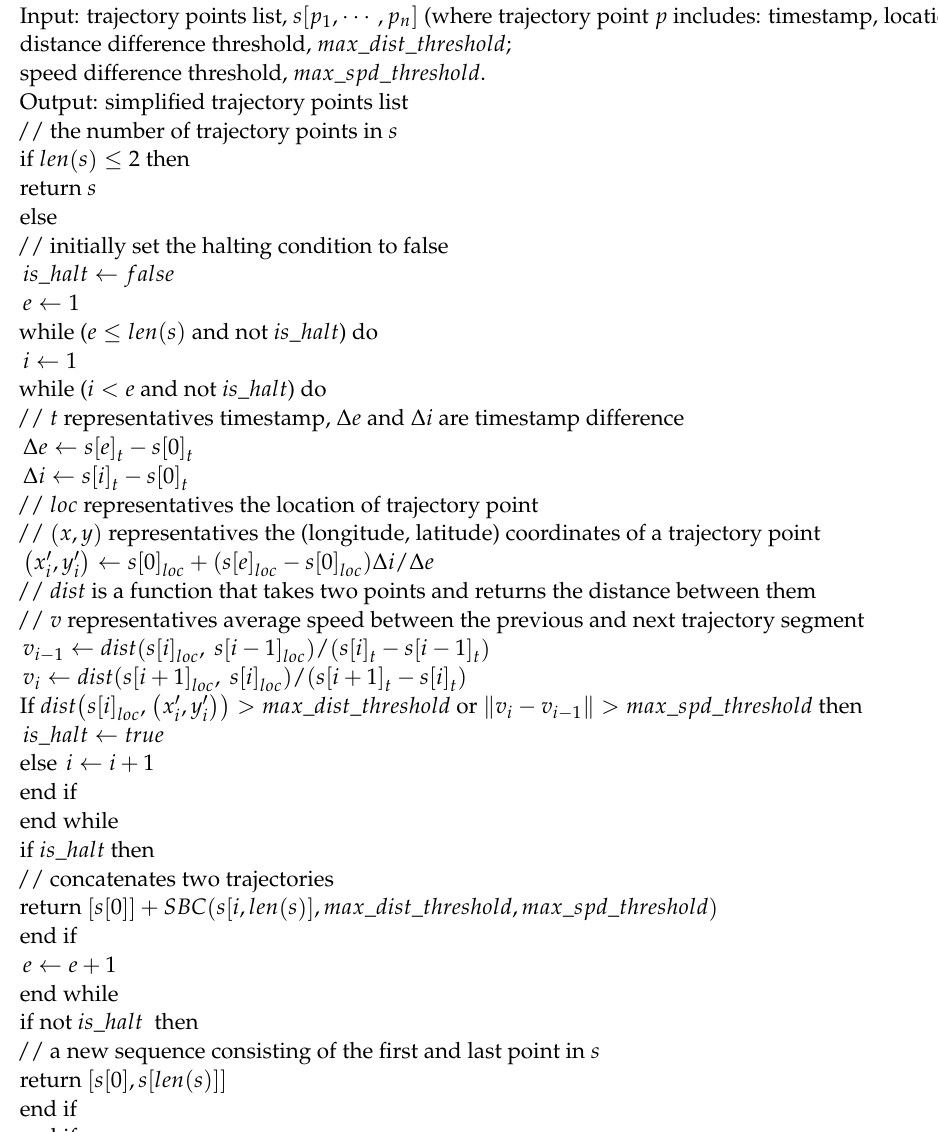
Algorithm 1: simplification algorithm considering vessel behavioural characteristics